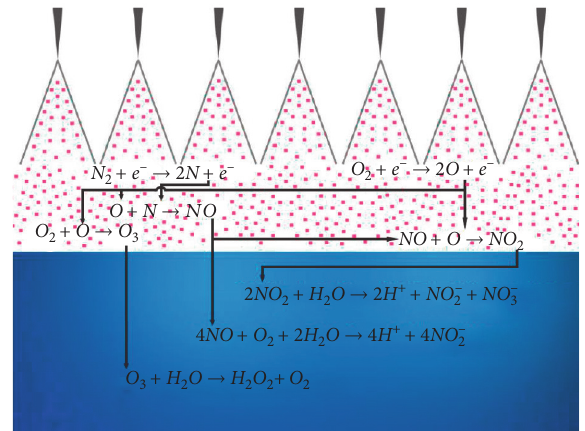
Figure 2: Chemical reaction pathway of plasma-activated